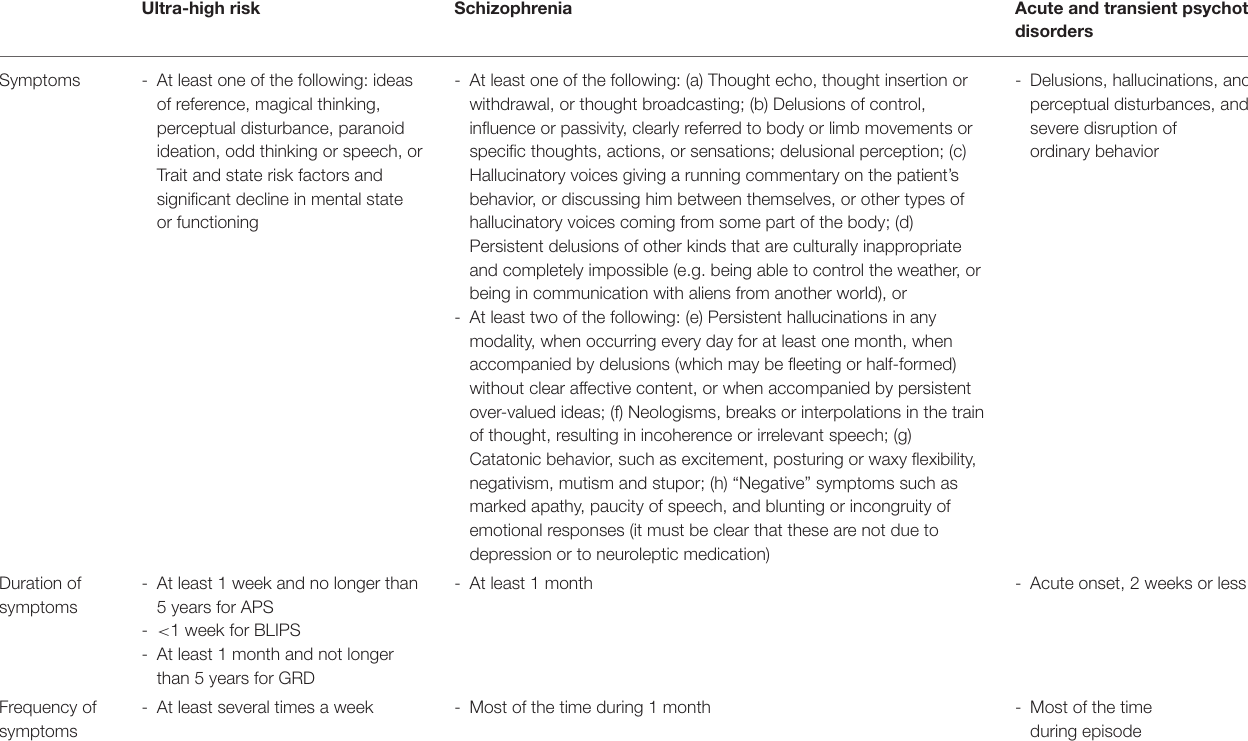
TABLE 1 | Diagnostic criteria of ultra-high risk (12), schizophrenia (18) and acute transient disorder